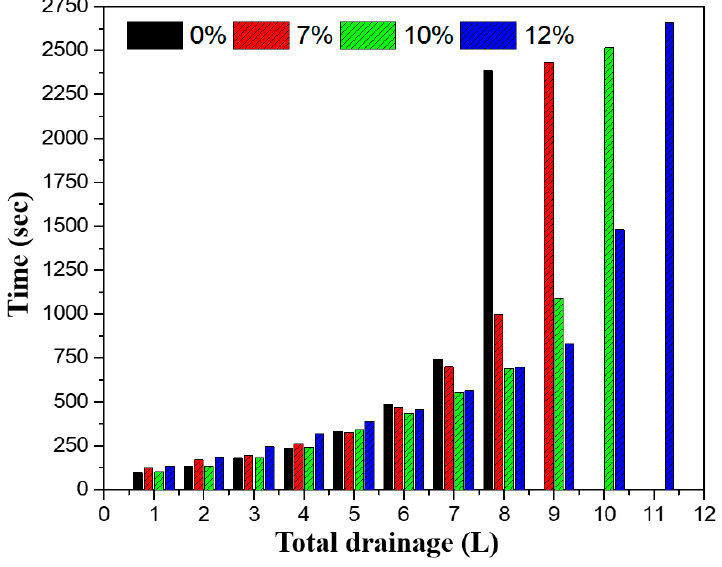
Figure 9. Total drainage versus time for soil samples.